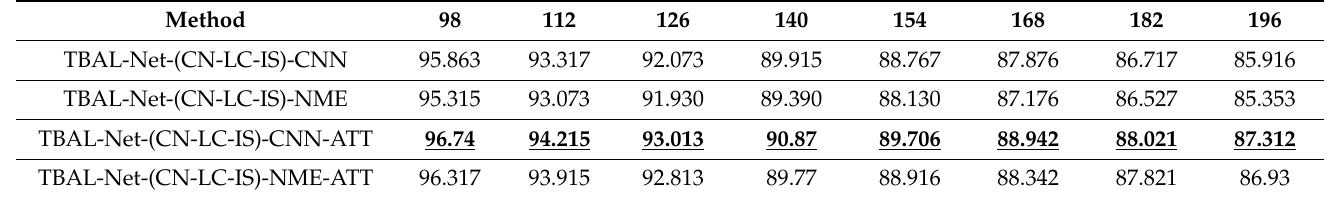
Table 4. Performance of TBAL-Net with/without attention modules on Stanford-Car (Top-1 Accuracy).